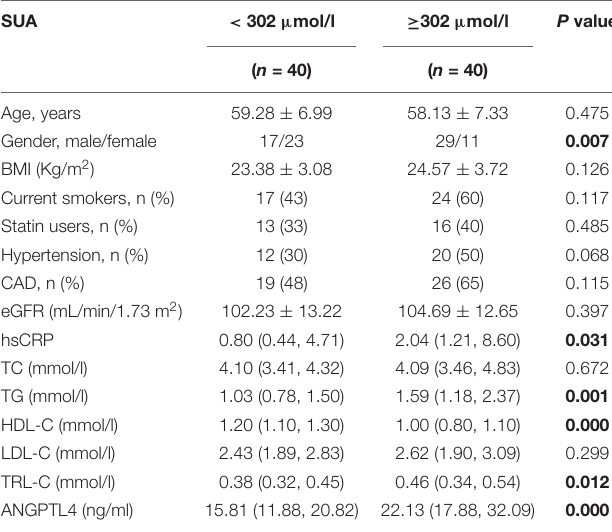
TABLE 1 | Clinical characteristics of the study population according to the median value of SUA levels (302 µ mol/l). SUA < 302 µ